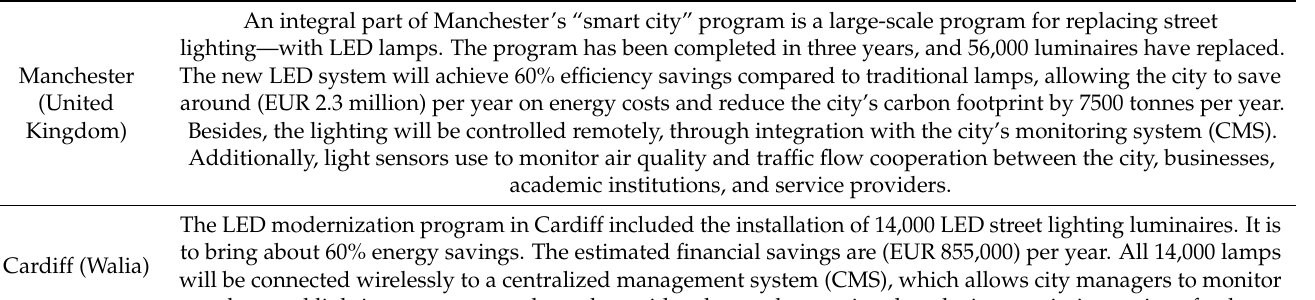
Table 2. Examples of integrating outdoor LED lighting with smart city